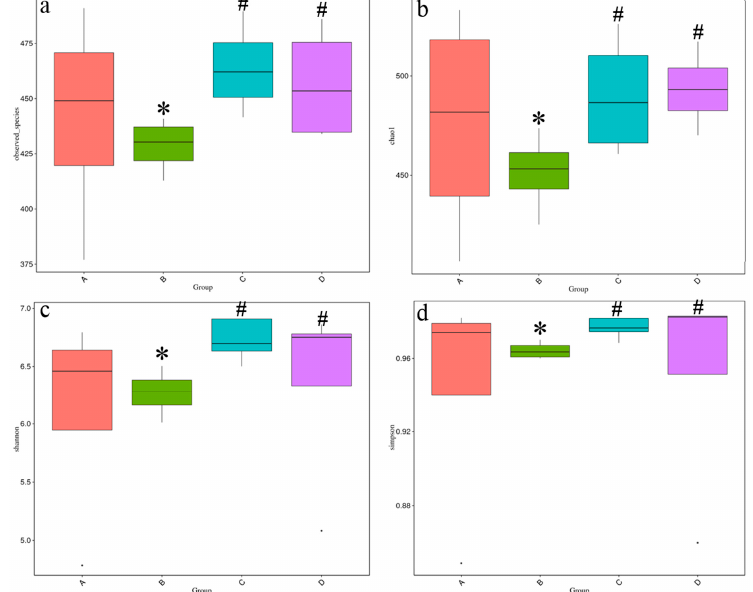
Figure 4. Alpha diversity of caecal microbiota between groups ( n = 4 in each group). Note: * shows a statistical significant difference compared with the control group with standard diet ( p < 0.05). # shows a statistical significant difference compared with the high-salt diet group ( p < 0.05). A: control group with standard diet (0.4% NaCl); B: high-salt diet (4.0% NaCl); C: high-salt diet (4.0% NaCl) with 0.5% betaine; D: high-salt diet (4.0% NaCl) with 1.0% betaine; ( a ) Observed_species; ( b ) Chao1 index; ( c ) Shannon index; ( d ) Simpson index.